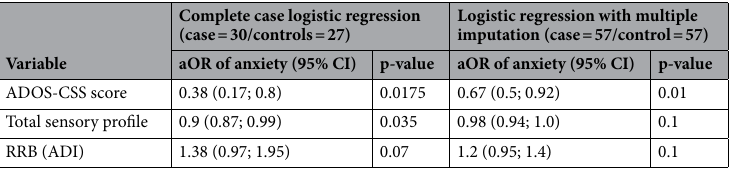
Table 3. Multivariables logistic regression models. *Adjusted on anxiety level and IQ at T1. ADOS-CSS autism diagnostic observation schedule calibrate severity scale, RRB restrictive repetitive